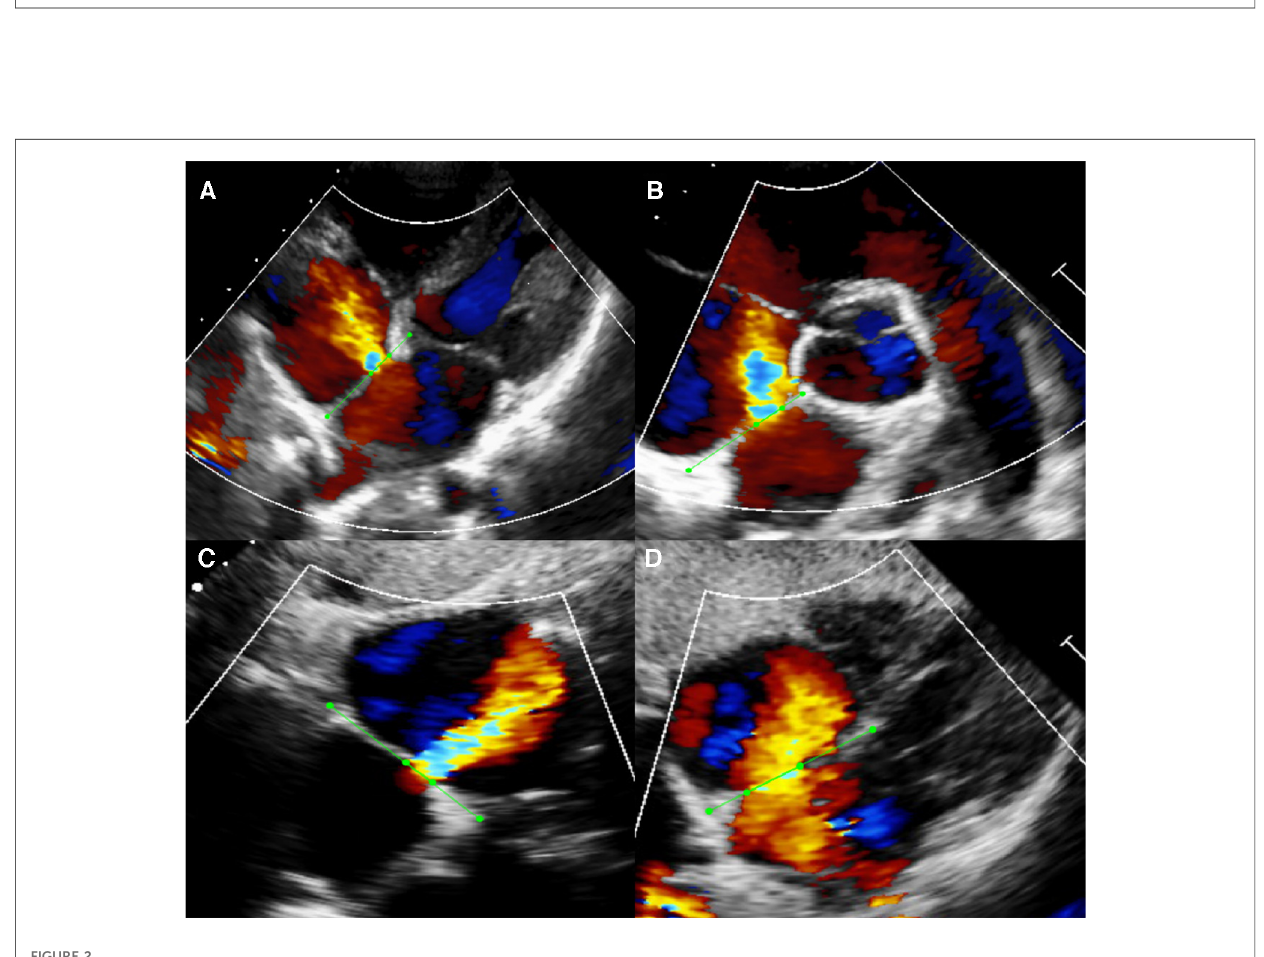
FIGURE 2 Example of manual segmentation. Green dots were manually labeled as the endpoints of atrial septum and defect with the open-source program LabelMe. ( A ) Modi fi ed apical four-chamber view (A4C). ( B ) Parasternal short-axis view (PSAX). ( C ) Subxiphoid sagittal view (SC2A). ( D ) Subxiphoid four- chamber view